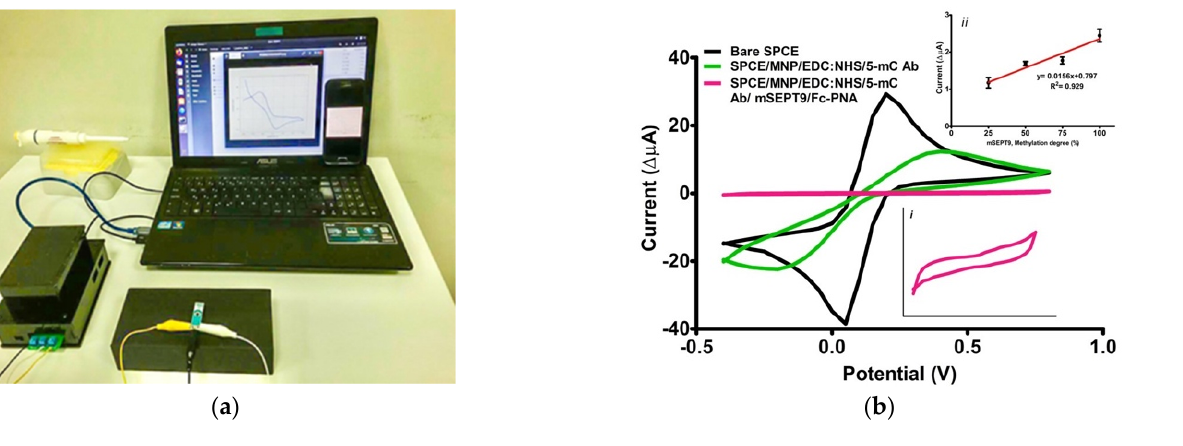
Figure 7. ( a ) Measurement display with design POC. ( b ) CV results with POC [Measurement for SPCE/MNP/EDC/NHS/5-mC Ab/mSEPT9/Fc-PNA was shown in the inset (i). Calibration curve was generated with POC was shown in the inset (ii)]. [Electrochemical cell containing 0.1 M KCl and 5.0 mM HCF in 1X PBS buffer (pH 7.4) was used for measurements of Bare SPCE; SPCE/MNP/EDC/NHS/5-mC Ab steps. The electrochemical cell containing 0.1 M KCl in 1X PBS buffer (pH 7.4) was used for the measurement after addition of the mSEPT9/Fc-PNA hybridization.].